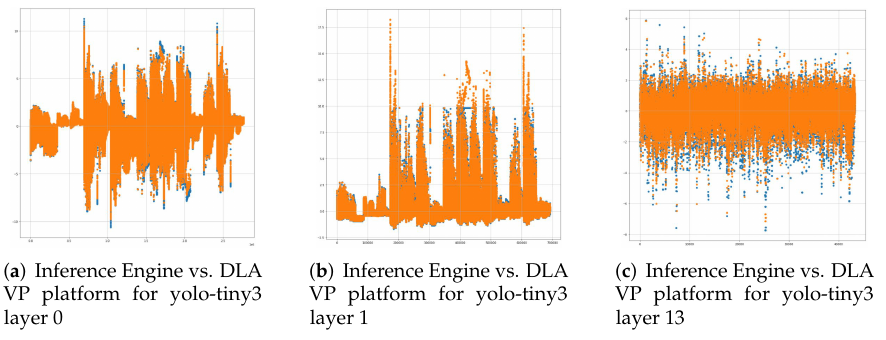
Figure 10. Comparison of each pixel values of inference operation with inference engine and DLA VP platform that execute layers 0, 1, and 13 of Darknet yolov3-tiny: ( a ) CNN of 416 × 416 size with 16 filters, ( b ) max pooling of 416 × 416 size, ( c ) CNN of 13 × 13 size with 1024 filters. In the figure, pixel values of inference engine are plotted with blue points while pixel values of DLA VP are plotted with orange